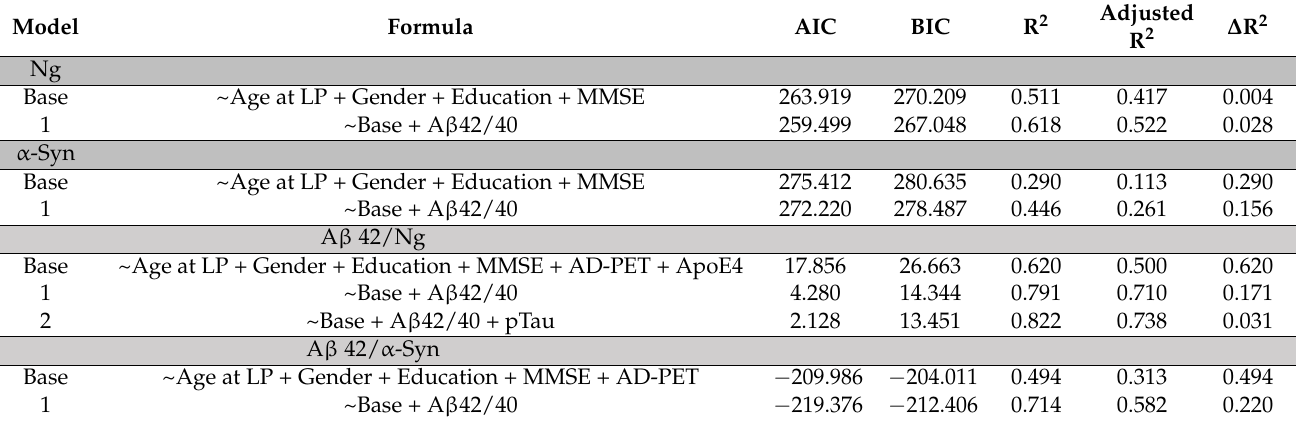
Table 6. Competitive hierarchical linear regression